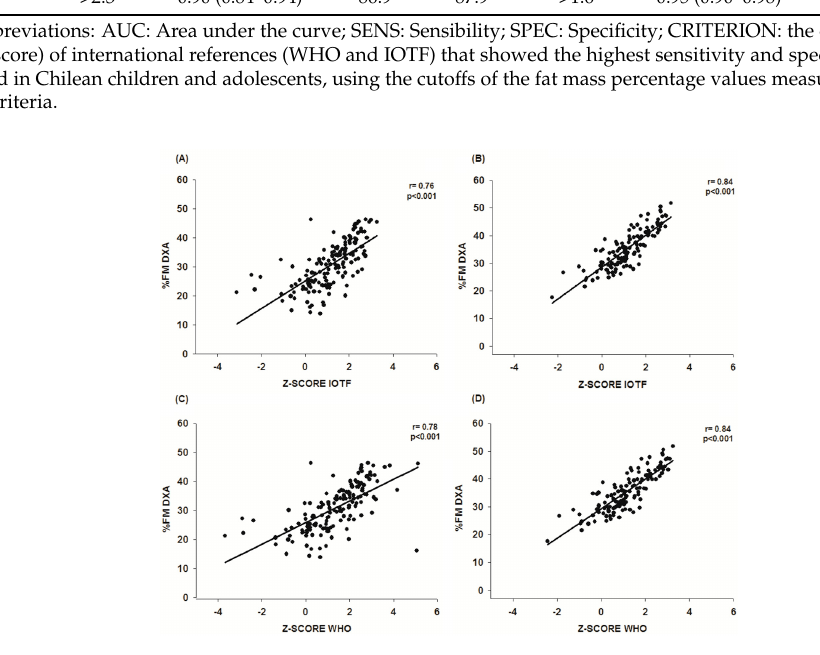
Figure 1. Correlation between the %FM measured by the DXA and the Z-score: boys ( A ) and girls ( B ) classified by the IOTF [12]: and boys ( C ) and girls ( D ) classified by the WHO [13] in the sample of Chilean children and adolescents.